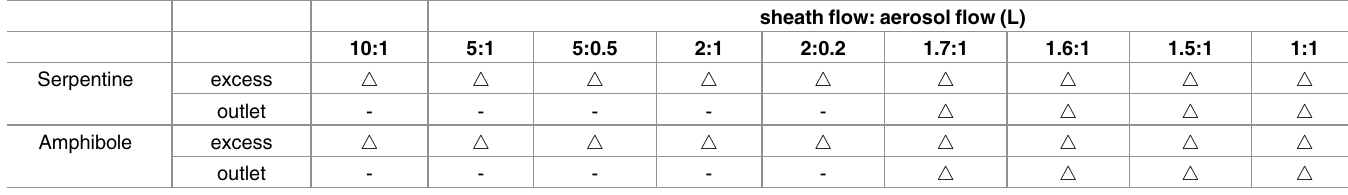
-: fibrous materials were not observed, 4 : a mixture of fibrous and particulate materials was observed, outlet: only fibrous materials that passed through was observed, excess: where fibrous and particulate materials that did not pass through were